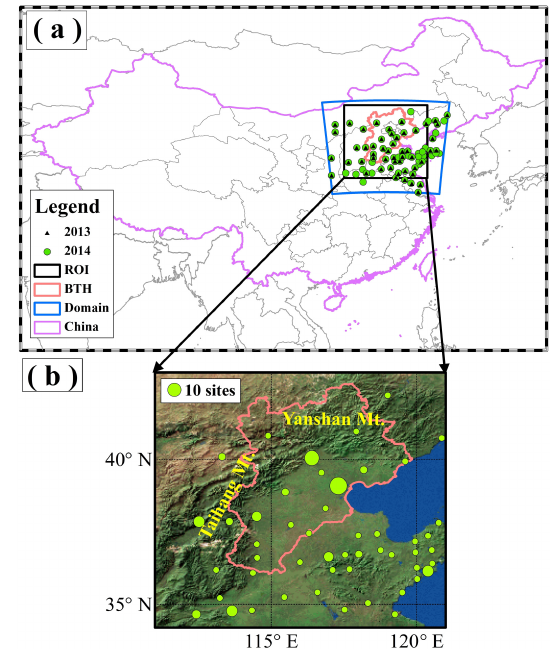
Figure 1. (a) The model domain, region of interest (ROI), and monitoring sites. (b) The topography and monitoring sites in Jan- uary 2014. The circles represent the centers of cities with ambient monitoring sites, and the size of circles denotes the number of moni- toring sites in the cities. The boundary of BTH region is highlighted with bright lines. The Yan (Yanshan Mt.) and Taihang Mountains are also